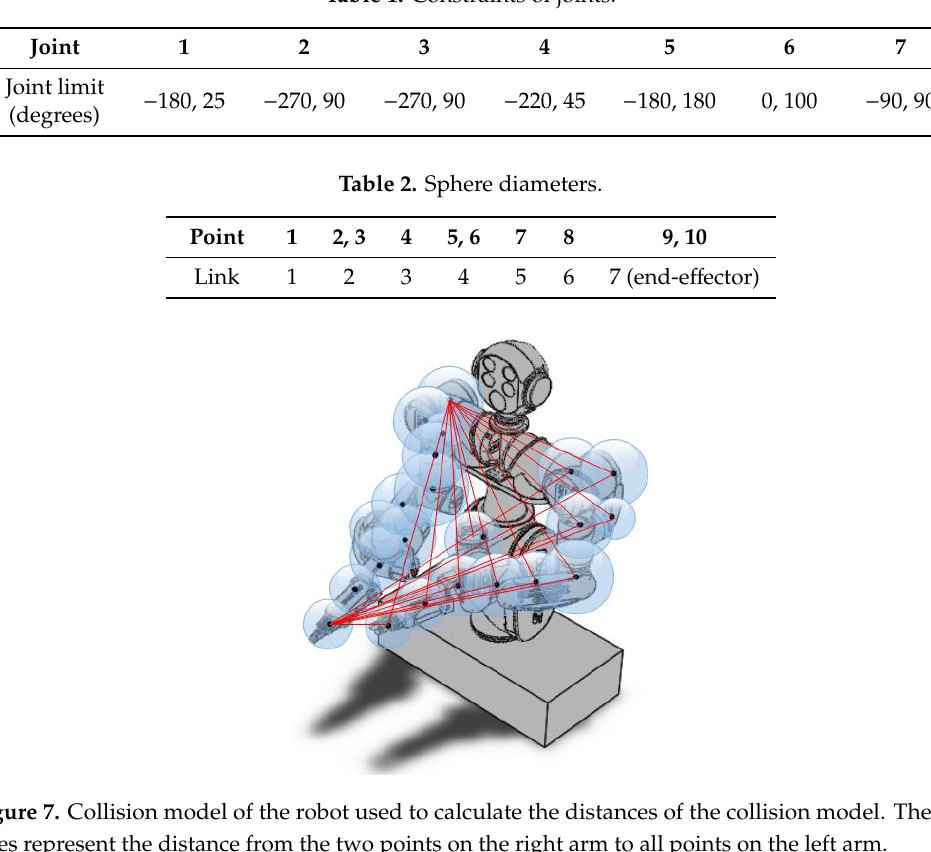
Table 1. Constraints of joints.